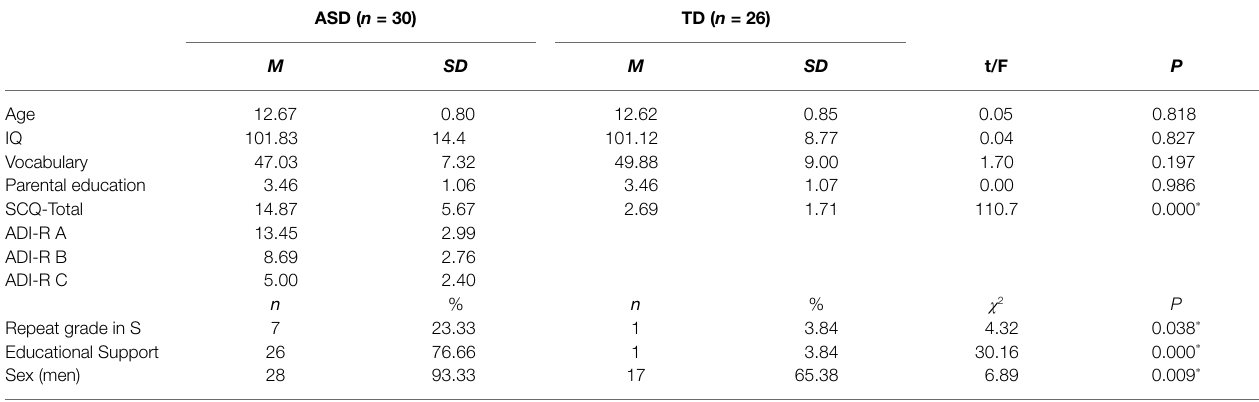
TABLE 1 | Socio-demographic